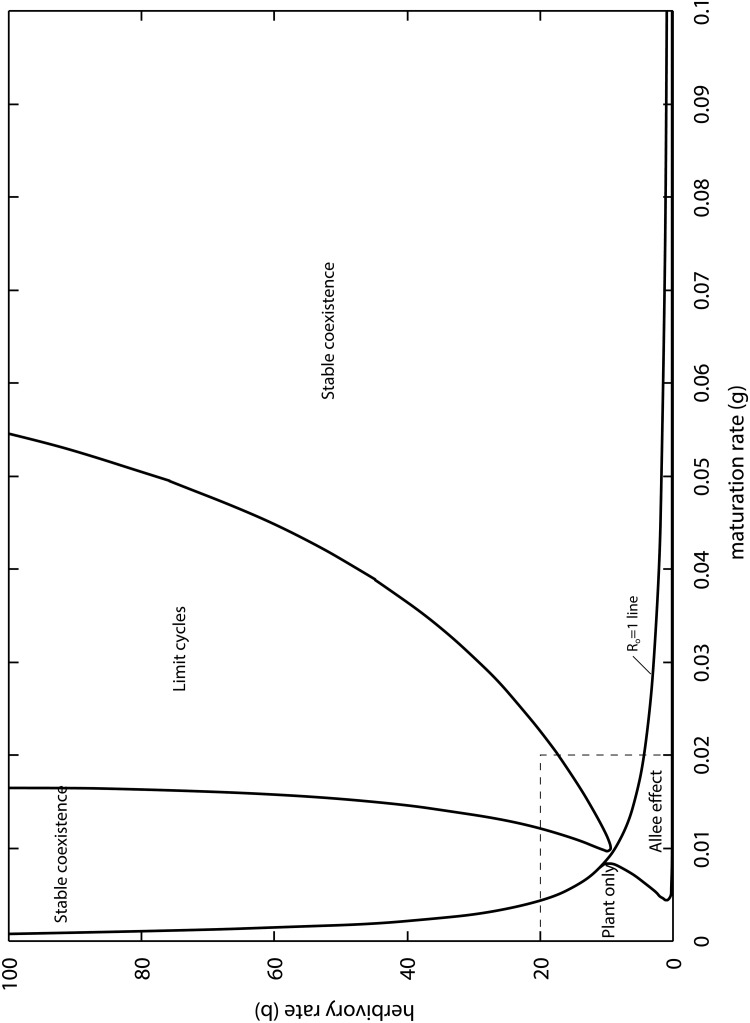
Outcomes of the PLA model as a function of the larval maturation and herbivory rates for specialist pollinators (ϕ = 0).The rectangular region in the bottom left is analyzed with more detail in S1 File.